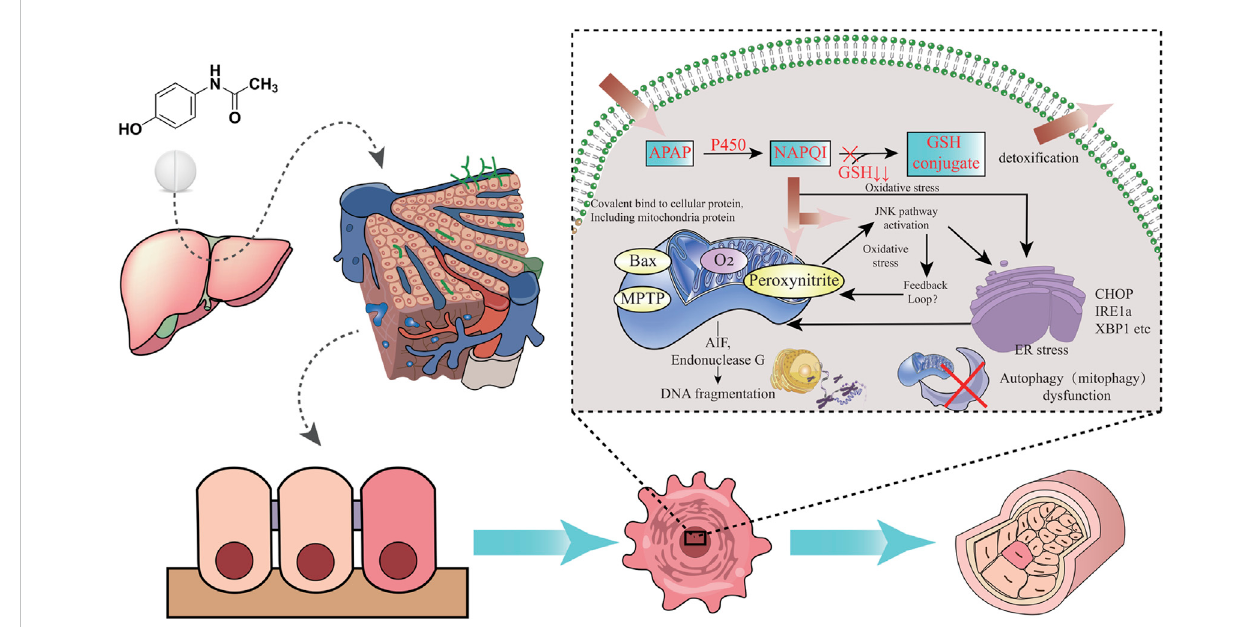
FIGURE 4 Molecular mechanism of APAP-induced hepatotoxicity is revealed through integrated pathways, including oxidative stress and ER